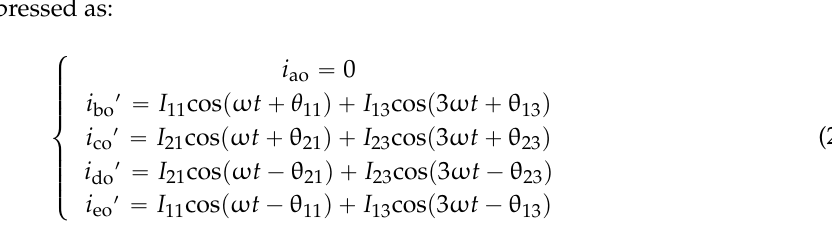
Figure 11. Single ‐ phase open ‐ circuit fault in the outer motor. ( a ) Outer motor; ( b ) inner motor. Figure 11. Single-phase open-circuit fault in the outer motor. ( a ) Outer motor; ( b ) inner motor.